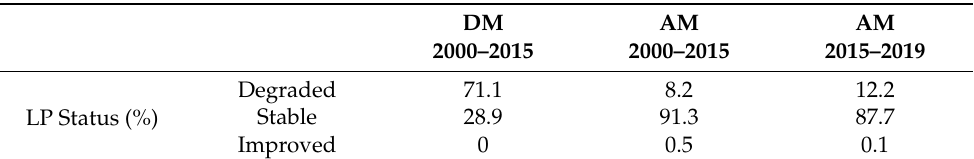
Table 3. The land productivity (LP) status in percent for the default (DM) and adapted methods (AM) for the baseline period from 2000 to 2015, as well as for the first monitoring period of 2015-2019. Furthermore, the land cover share of the degraded area in the target year is depicted.